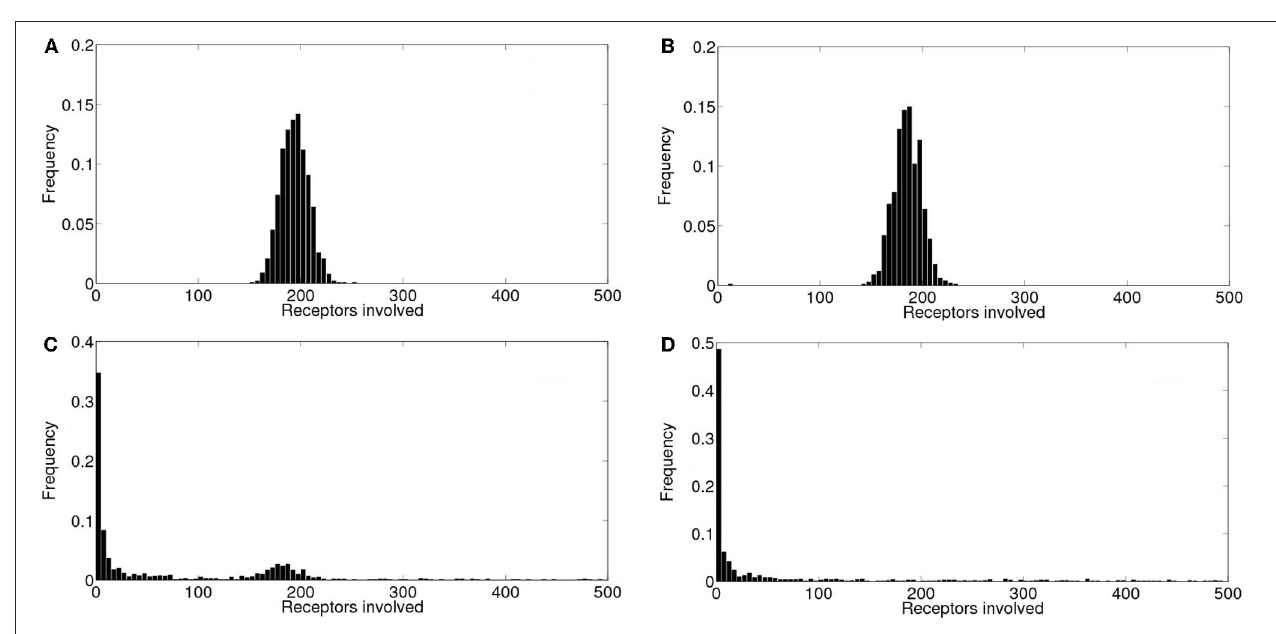
values used in section 5 except for the cytosolic Ca 2 + clearing rate for which we used: ( A ) δ Ca = 20 / s, ( B ) δ Ca = 25 / s, ( C ) δ Ca = 30 / s, ( D ) δ Ca = 200 / s.